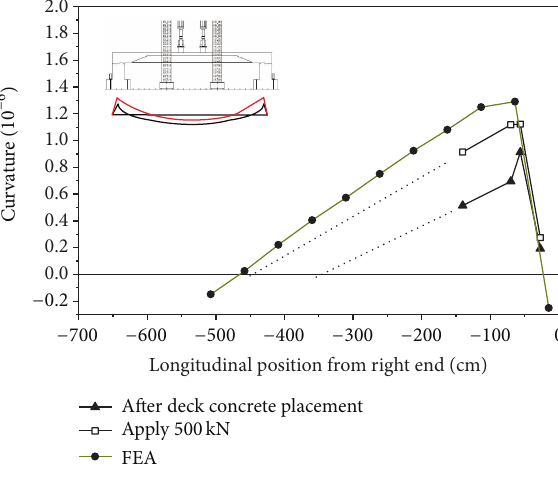
Figure 10: Prediction of curvature distribution.